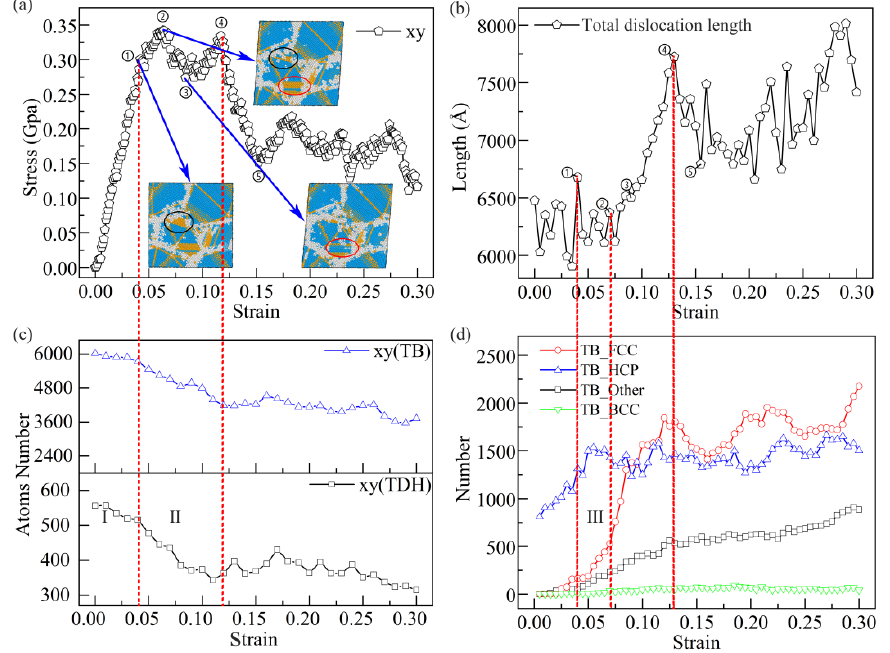
Figure 4. ( a ) Stress-strain curve and snapshots of some strain points. Changes in ( b ) dislocations, ( c ) TB atoms and TDH atoms, and ( d ) atoms transformed from TB to various structures. Stage A: elastic-deformation stage; Stage B: high-level stress stage.